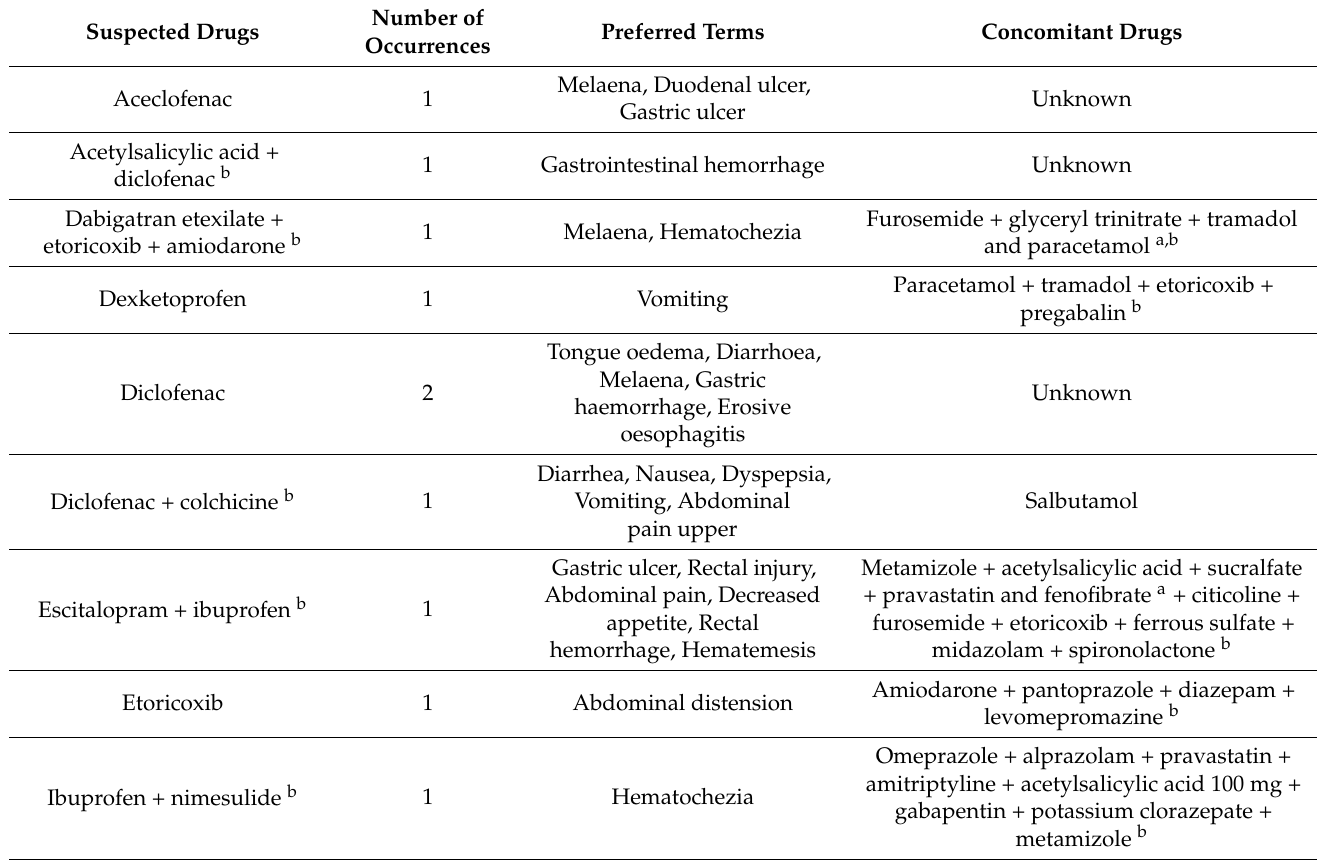
Figure 2. System organ classes (SOC) affected by suspected adverse drug reactions (ADR) reports spontaneously reported to the Portuguese Pharmacovigilance System from 2008 to 2018 for people aged 65 years or older: the top five. Table 2. Non-steroidal anti-inflammatory drugs and other drug classes associated with serious gastrointestinal events that resulted in life-threatening adverse events, caused patient hospitalization or prolonged